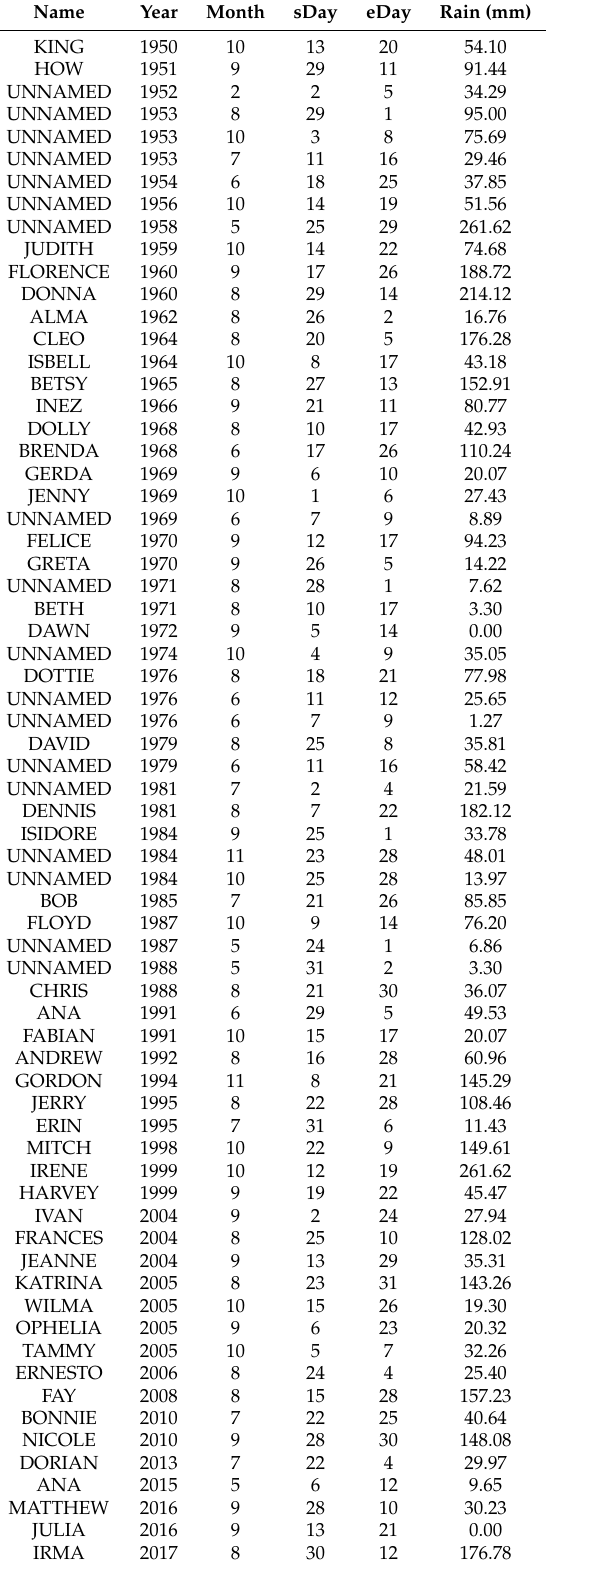
Table 2. Tropical cyclone data used for Miami, Florida. Included are the storm name, year, month, start day (sDay), end day (eDay), and accumulated rainfall in